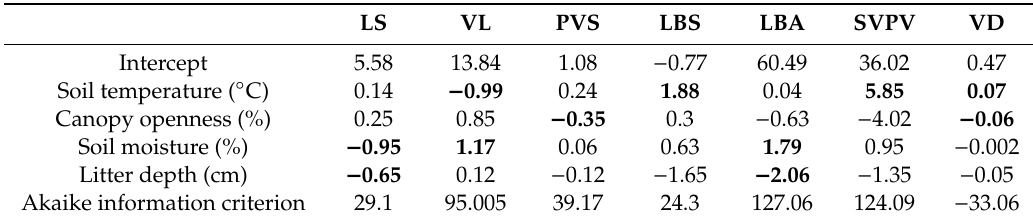
Table 2. Variable coe ffi cients used for the general linear model (GLM) model. Microenvironmental variables influencing the leaf vein traits [Leaf shape (LS); Vein length (VL); Primary vein size (PVS); Leaf base shape (LBS); Leaf base angle (LBA); Angle between major secondary veins and primary veins (SVPV); and Vein density